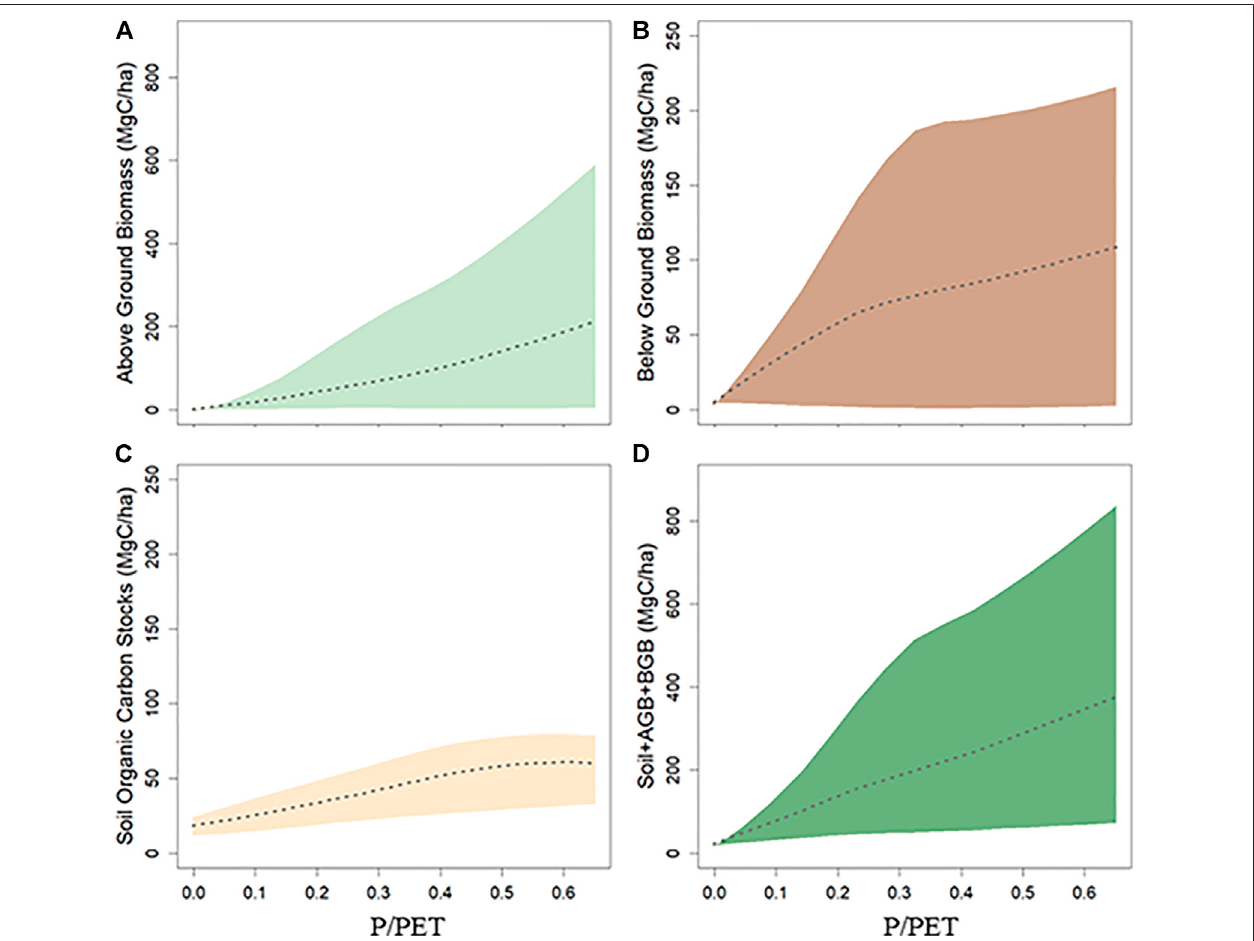
FIGURE 3 | Average and variability in carbon stocks in global drylands increases with increasing water availability (P/PET). (A) Above ground biomass carbon, (B) Belowgroundbiomasscarbon, (C) Soilorganicmatterinthe fi rst30 cm,and (D) Summedtotalcarbon.Plotsshowmeans(dottedlines)andthe5thand95thpercentiles using local polynomial regression fi tting for the datasets shown in Figure 2 . Note, change in y -axis scale for (A,D) relative to (B,C) .